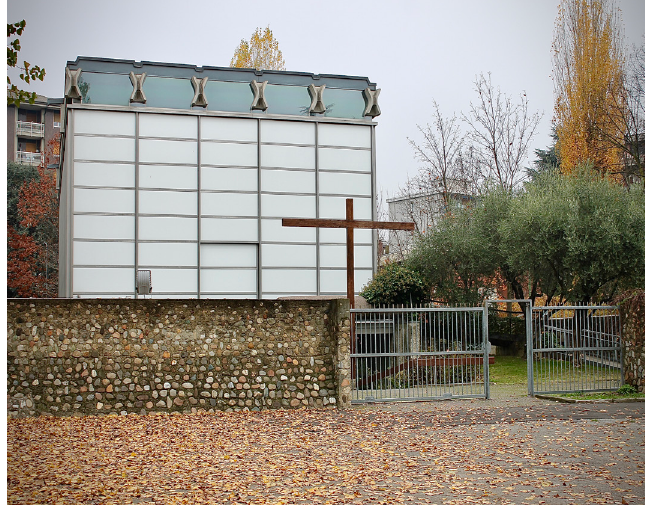
of Baranzate (built in